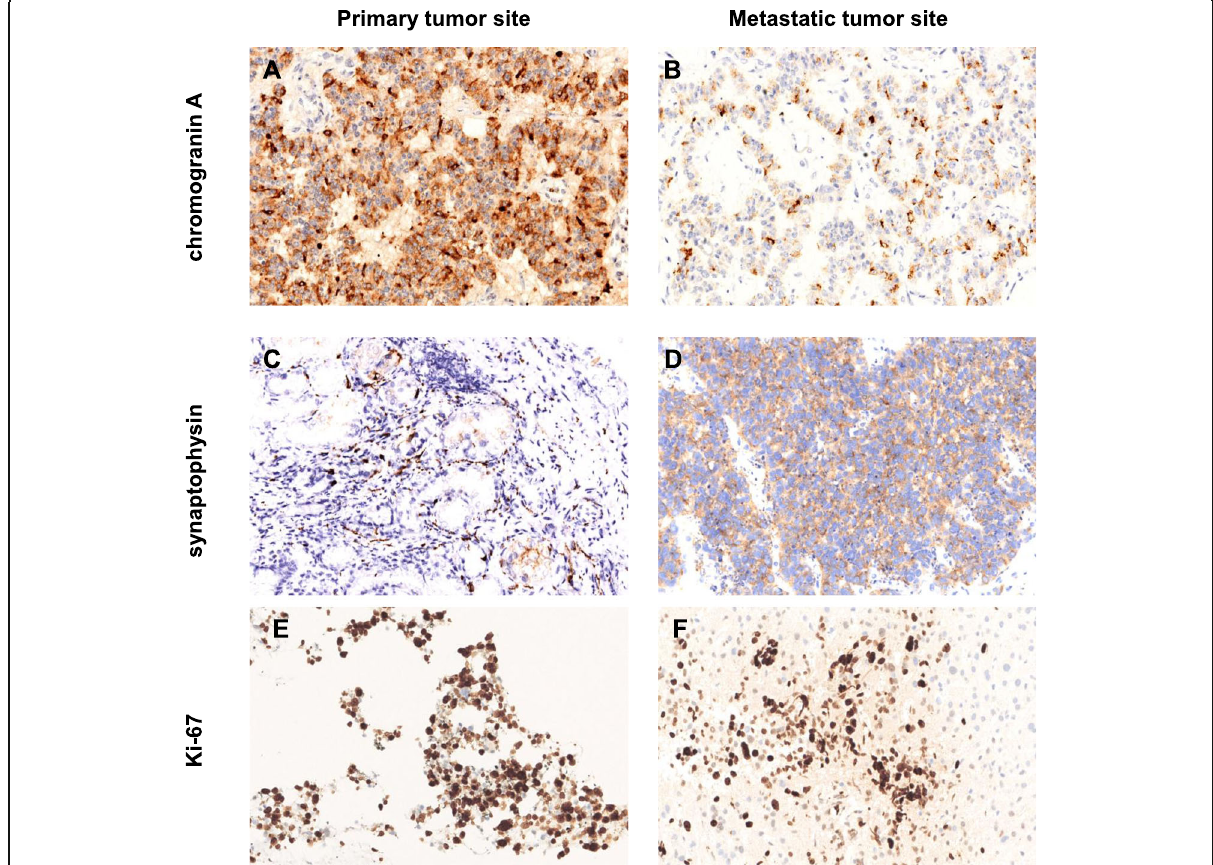
Fig. 1 Examples of CgA staining images in the primary pancreatic NEN ( a ) and mesenteric metastasis ( b ) from the patient # 5, magnification 200×. Examples of Syn staining images in the primary gastric NEN ( c ) and hepatic metastasis ( d ) from the patient # 26, magnification 200×. Examples of Ki-67 labeling in the primary pancreatic NEN ( e ) and hepatic metastasis ( f ) from the patient # 6, magnification 200